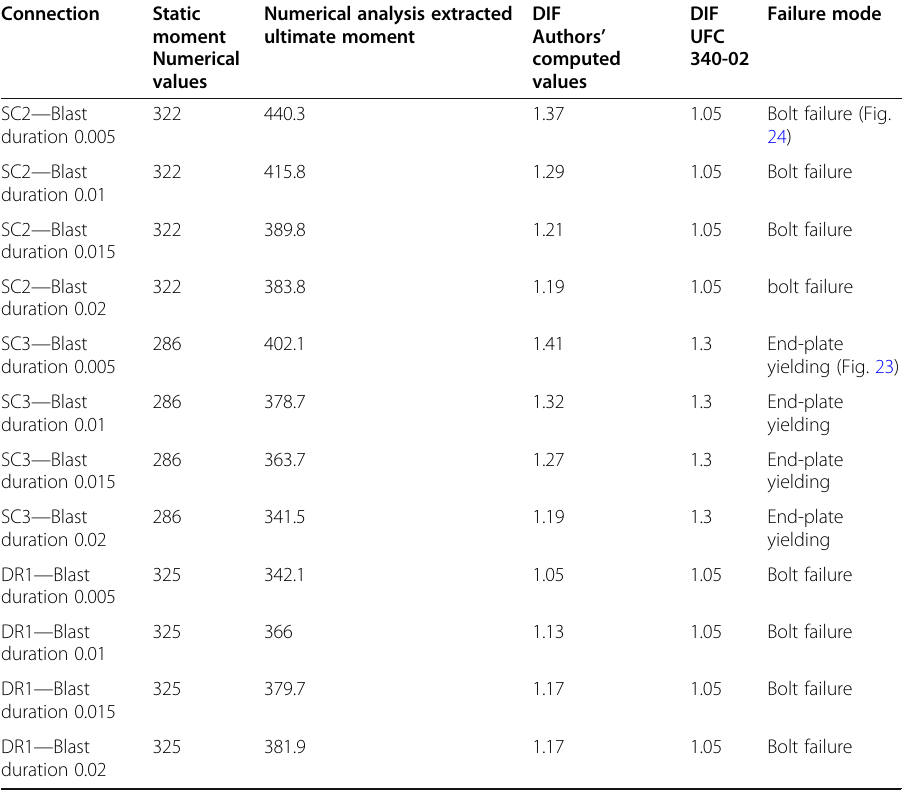
Table 4 Comparing ultimate moments obtained by numerical models vs. values calculated by UFC 340-02, design guides No. 16 and 26, in addition to